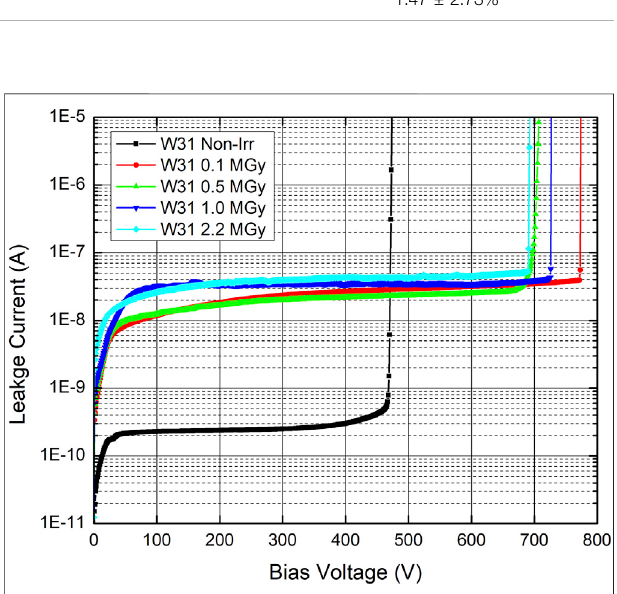
FIGURE 6 | Sample current versus voltage characteristics for p-i-n diodes from Wafer 31, for several values of total ionizing dose.